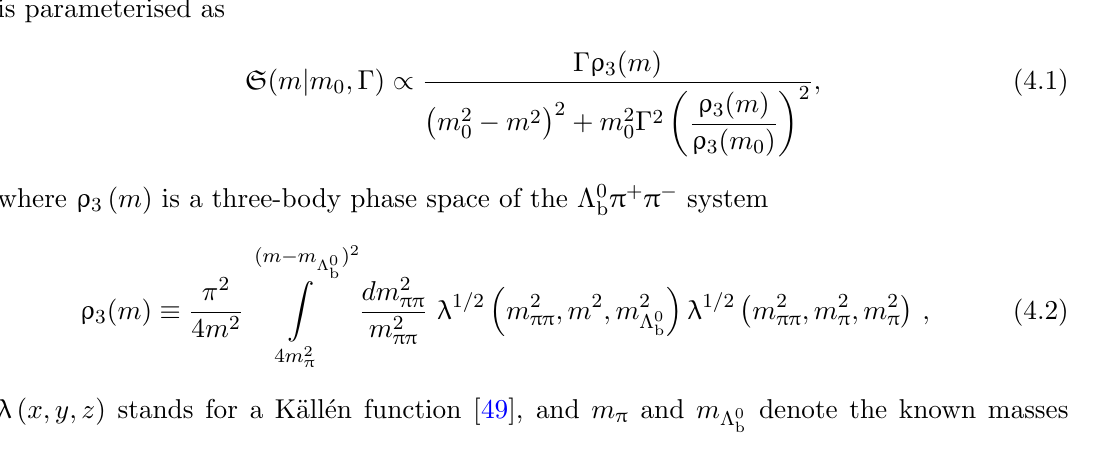
Figure 3 . Mass spectra of selected (top) (cid:3) 0 binations for the (cid:3) 0 J = pK (cid:0) sample. A simultaneous (cid:12)t, described in the text, is b !